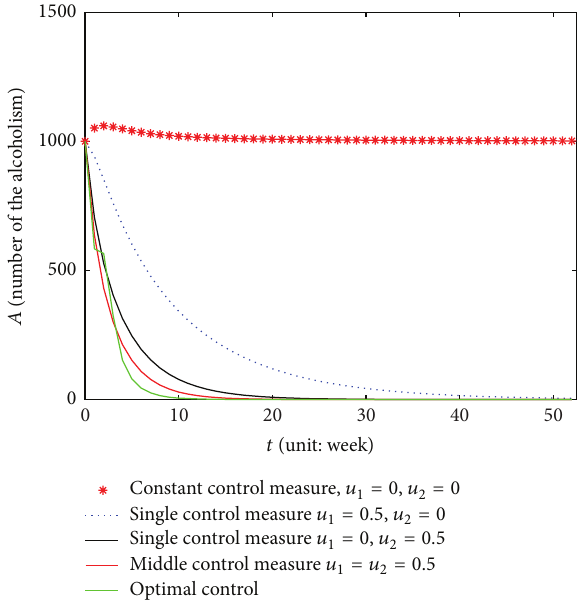
Figure 12: Number of the alcoholics when we choose the weights in objective function are 𝑐 1 = 10 4 , 𝑐 2 = 10 2 and under different optimal control strategies, that is, (1) without control: 𝑢 1 = 𝑢 2 = 0 ; (2) single control: 𝑢 1 = 0.5 , 𝑢 2 = 0 ; (3) single control: 𝑢 1 = 0 , 𝑢 2 = 0.5 ; (4) middle control: 𝑢 1 = 𝑢 2 = 0.5 ; (5) optimal control: 𝑢 1 = 𝑢 ∗ 1 , 𝑢 2 = 𝑢 ∗ 2 .